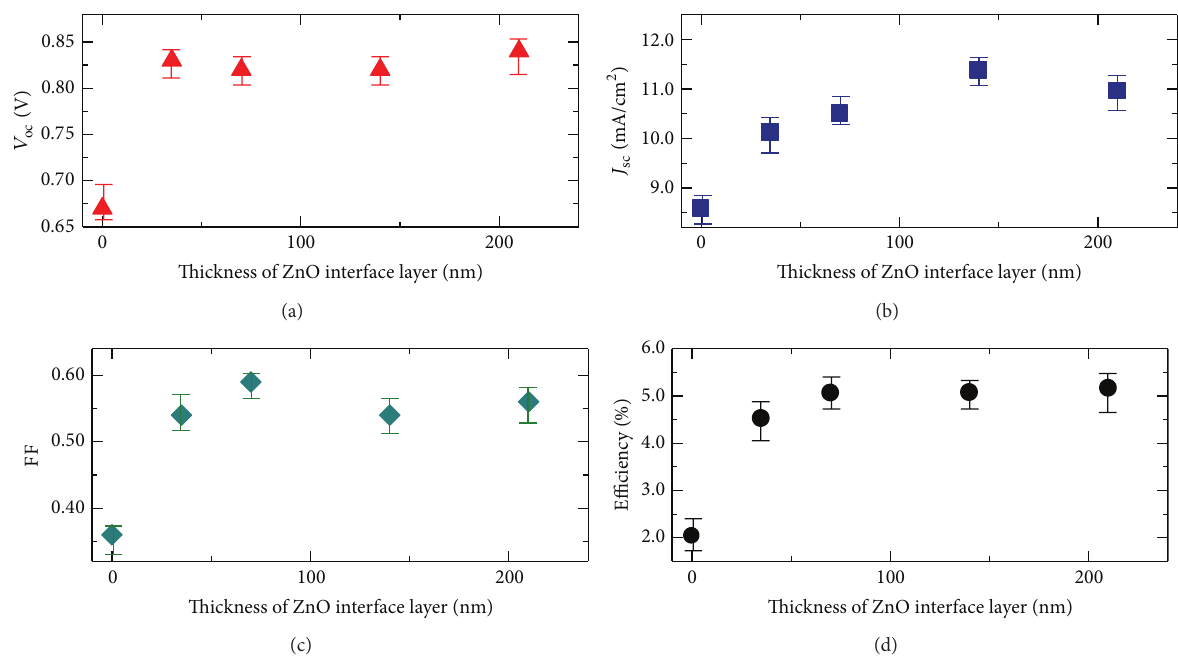
Figure 2: Photovoltaic parameters of flexible n-i-p amorphous silicon solar cells using the MOCVD ZnO/screen printed Ag back reflector as a function of thickness of the sputtered ZnO interface layer.